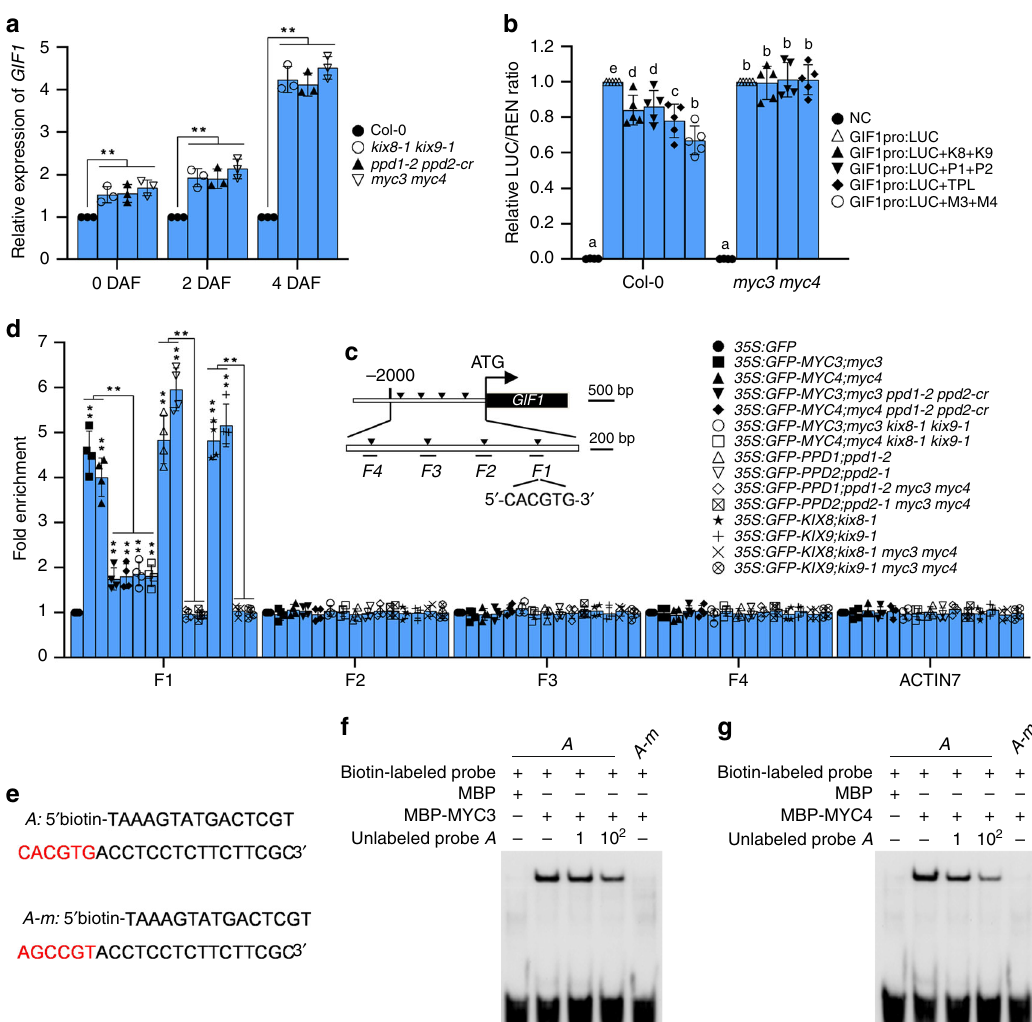
Fig. 4 The KIX-PPD-MYC complex associates with the promoter of GIF1 and represses its expression. a The relative expression levels of GIF1 in the 0, 2 and 4 DAF (days after fl owering) siliques of Col-0, kix8 - 1 kix9 - 1 , ppd1 - 2 ppd2 - cr and myc3 myc4 were detected by qPCR ( n = 3). Data was normalised with ACTIN2 . b The LUC activity of GIF1pro : LUC from the transient expression analysis in the Col-0 and myc3 myc4 protoplast ( n = 5). GIF1pro : LUC was cotransfected with different combinations of 35S : Myc - KIX8 (K8), 35S : Myc - KIX9 (K9), 35S : Myc - PPD1 (P1), 35S : Myc - PPD2 (P2), 35S : Myc - MYC3 (M3), 35 S : Myc - MYC4 (M4), and 35S : Myc - TPL (TPL) into the Col-0 and myc3 myc4 protoplast. The LUC and REN luciferase activities of GIF1pro : LUC were measured 40 h later after transfection. NC ( pGreen II_0800 - LUC ) was used as a negative control. c The schematic diagram of GIF1 promoter containing a typical G- box (5 ′ -CACGTG-3 ′ ) sequence in F1 fragment. F1 - F4 represent DNA fragments used for ChIP-qPCR analysis. d ChIP-qPCR assays showing that KIX8/9 and PPD1/2 associate with the promoter of GIF1 by MYC3/4 in Arabidopsis ( n = 4). Chromatin from 1 to 4 DAF siliques of 35S : GFP , 35S : GFP - MYC3 ; myc3 , 35S : kix9-1 , 35S : GFP - PPD1 ; ppd1 - 2 , 35S : GFP - PPD2 ; ppd2 - 1 , 35S : GFP - PPD1 ; ppd1 - 2 myc3 myc4 , 35S : GFP - PPD2 ; ppd2 - 1 myc3 myc4 , 35S : GFP - KIX8 ; kix8 - 1 , 35S : GFP - KIX9 ; A + G magnetic beads. The enrichment of fragments was determined by qPCR. The 35S : GFP plants acted as a control. The ACTIN7 promoter was used as a negative control. e The sequence of A and A - m probes for EMSA analysis. f , g The associations of MBP-MYC3 ( g ) and MBP-MYC4 ( i ) with the promoter of GIF1 were detected by EMSA. 5 ′ -biotin- A / A - m probes were incubated with MBP or MBP-MYC3/4 and detected by ChIP western blot with the anti-biotin antibody. Error bars represent ±SE. Asterisk indicates signi fi cant difference, one-way ANOVA P -values: ** P < 0.01. Different lowercase letters above the columns indicate the signi fi cant difference among different groups, one-way ANOVA P -values: P <